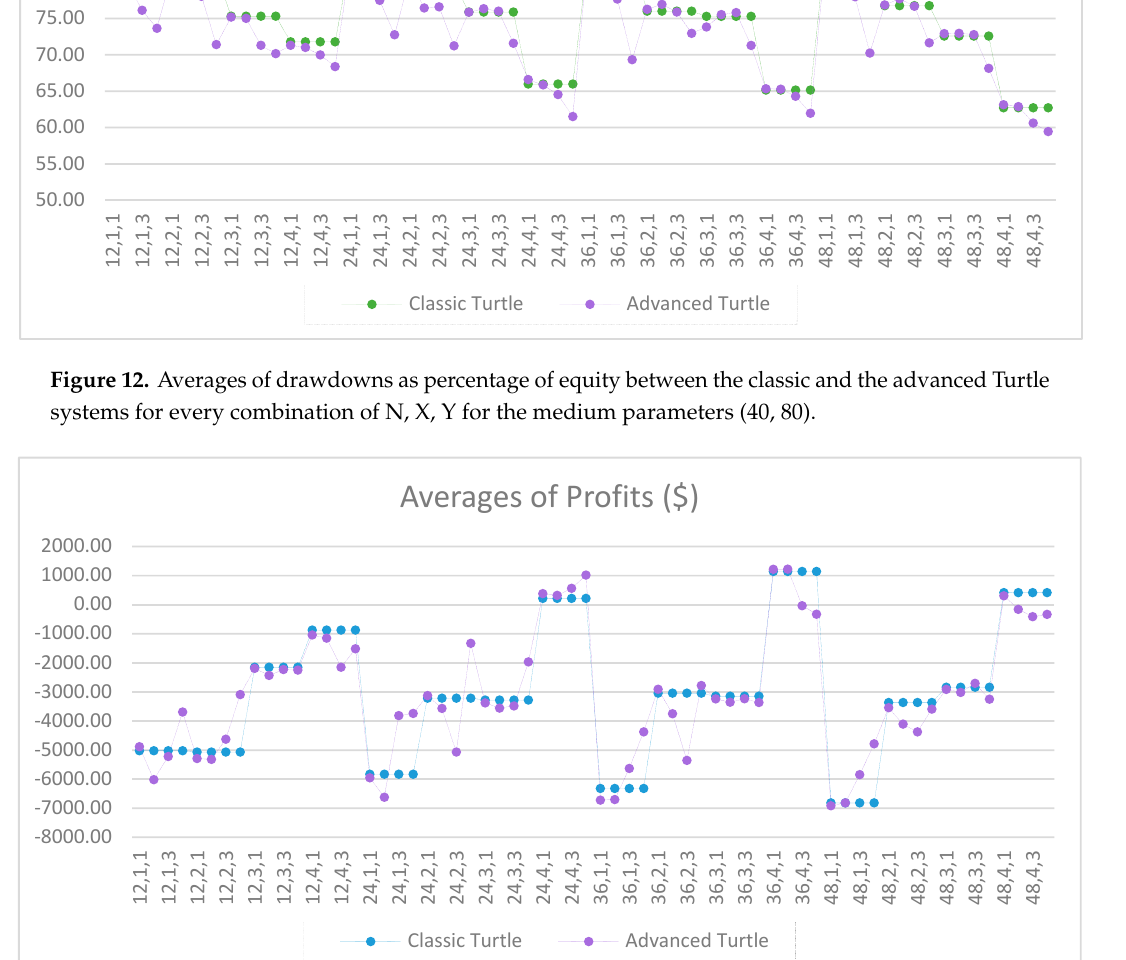
Figure13. AveragesofprofitsbetweentheclassicandtheadvancedTurtlesystemsforeverycombination Figure 13. Averages of profits between the classic and the advanced Turtle systems for every of N, X, Y for the slow parameters (80, combination of N, X, Y for the slow parameters (80, 160).